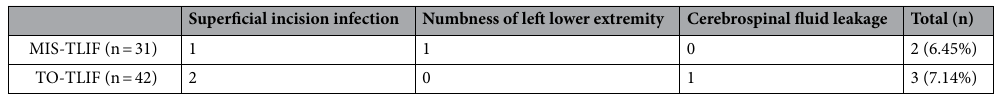
Table 5. Comparation of surgical-related complications between the two